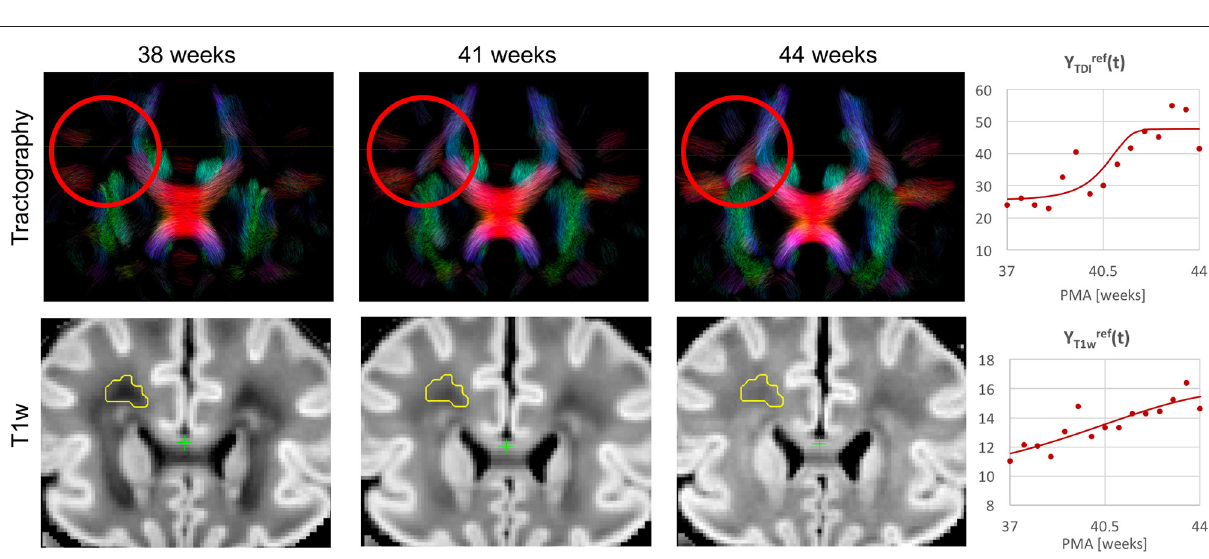
FIGURE 10 | Whole brain probabilistic tractography generated from the ODF channel Y ref ODF ( t ) and the corresponding T1w channel Y ref T 1 w ( t ) (in the reference space) in the frontal WM region at 38, 41, and 44 weeks PMA time points. The developing WM pathway (red circle) can be linked to the increasing T1w signal intensity (yellow region). The graphs show the signal in age-specific templates Y (2) c , t and fitted Gompertz function Y ref c ( t ) in the TDI and T1w channels averaged over the region highlighted in